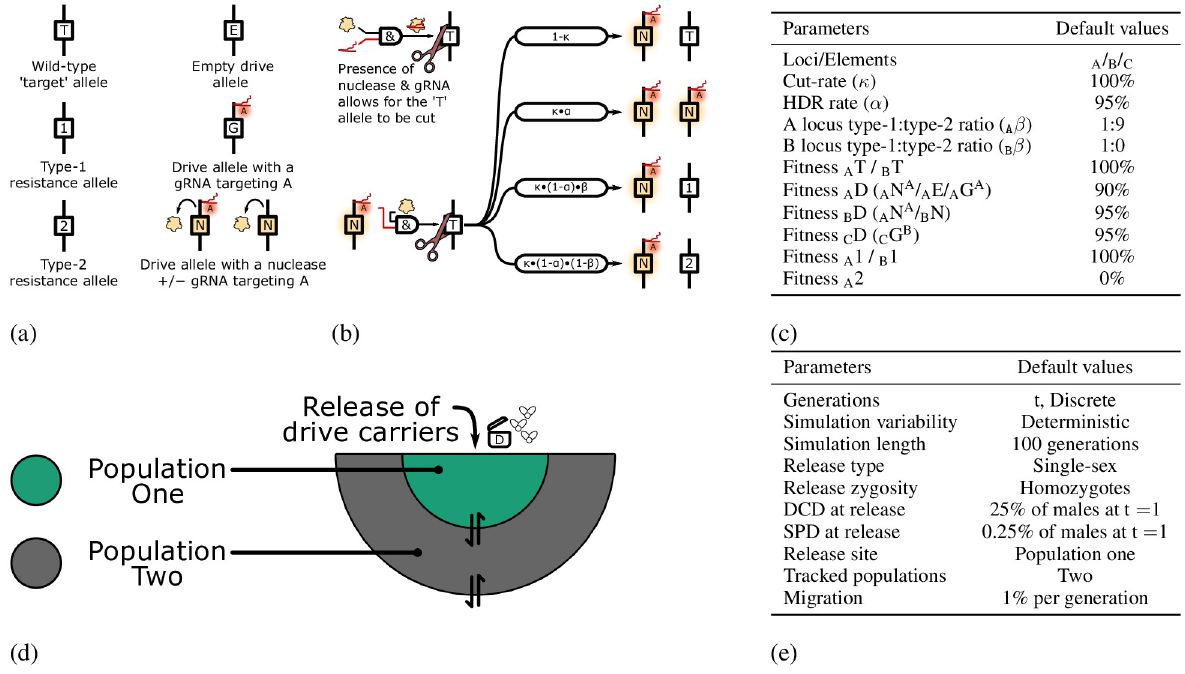
Fig 1. Drive nomenclature system and overview of simulation parameters. (a) Different alleles considered in our computational simulations: Wild-type target (T), type-1 resistance (1), type-2 resistance (2), and drive alleles (E, G, and N: collectively D). (b) When a target allele, a gRNA targeting that specific allele, and the nuclease are present in the same genotype, there is a certain likelihood that a cut occurs (by default 100%). The cut allele can be repaired by interhomolog HDR, or to a type-1 resistance allele or type-2 resistance allele. (c) Default nuclease and fitness parameters. The A drive allele has a fitness of 90% to account for general fitness costs (e.g., metabolic) and imperfect rescue of the haploinsufficient target gene by the drive element. This is the only fitness cost of the self-perpetuating gene drive. For DCDs, the B and C drive alleles have a fitness of 95%. Each fitness cost is dominant, with no additional recessive cost unless specifically listed for that simulation. Individuals carrying one or more of each different DCD allele are therefore assumed to have a fitness of 81% (90% � 95% � 95%). Type-2 resistance alleles at the A locus are assumed to be dominant lethal (fitness 0%). The B element is in a neutral locus; as such, its resistance alleles are all neutral and classified as type-1. The C locus is never cut, and resistance alleles are not generated at that locus. (d) Illustration of the two linked populations for which we report the allele frequency. Drive individuals are released into population one at the start of the simulation. Each generation, 1% of the surviving adults migrate to the neighbouring population. Population one receives 1% of population two, while population two receives 0.5% of population one and 0.5% of exclusively wild-types. (e) Default release frequency and simulation length parameters. DCD: Daisy-Chain Drive. SPD: Self-Perpetuating Drive.